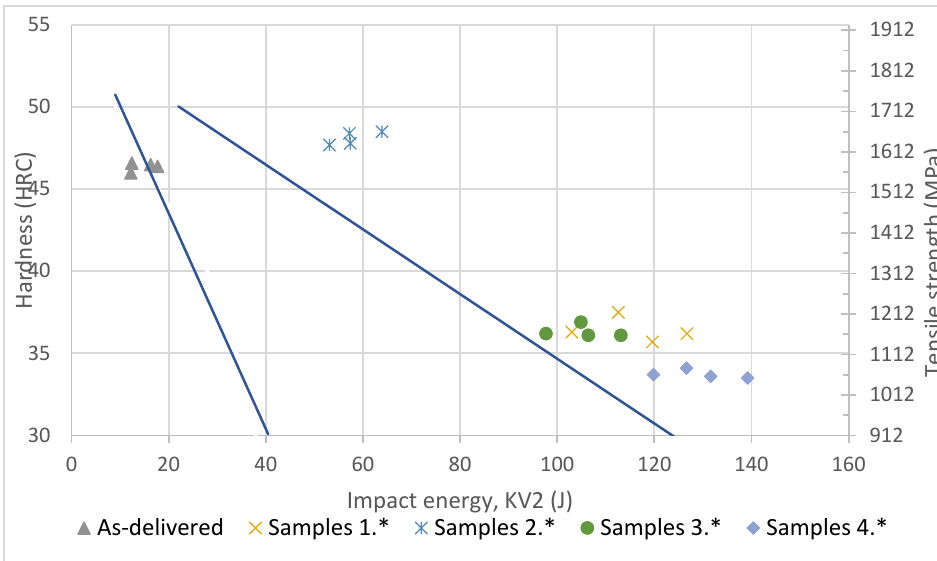
Figure 4. Comparison of pre- and post- treatment samples against similar steels’ properties .